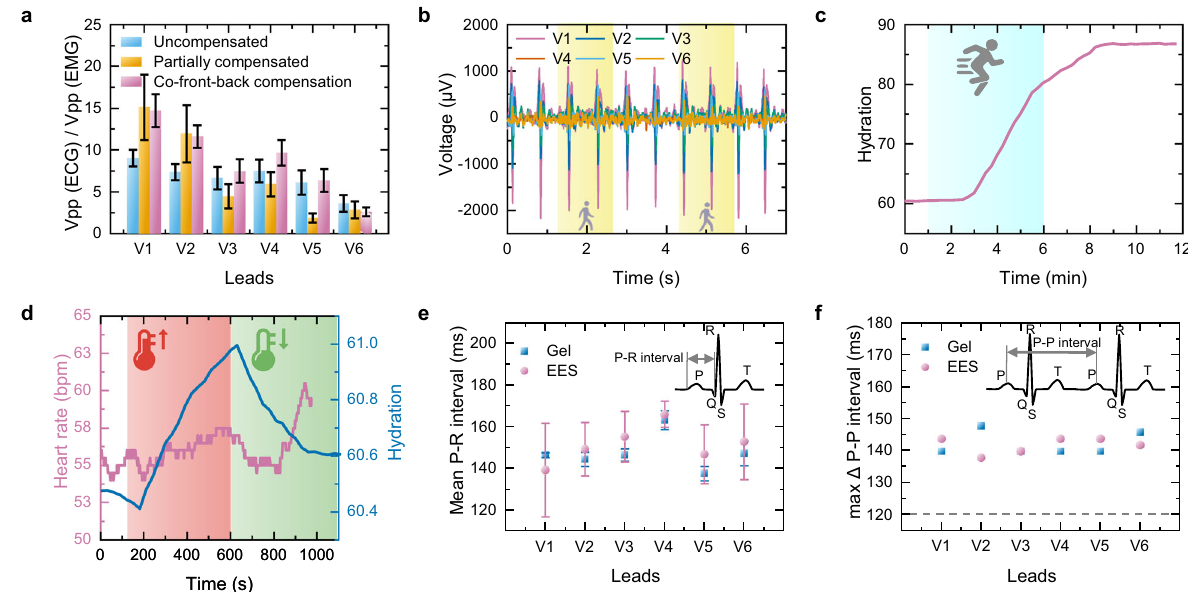
Fig. 4 EES in motion, temperature change, and disease screening. a Comparison of ECG and EMG intensity from V1 to V6 during chest exertion. Error bars represent the standard deviation of 3 measurements. b ECG during slow walking. c Hydration during running. d Heart rate and hydration index during environment temperature change. e Mean P-R interval over 5 cardiac cycles extracted by V1 – V6 ECGs of the subject with sinus arrhythmia, measured by EES and gel electrodes respectively. Error bars represent the standard deviation of the results from 5 different cardiac cycles. f The difference between the maximum and minimum P-P interval extracted from the same ECGs as ( e